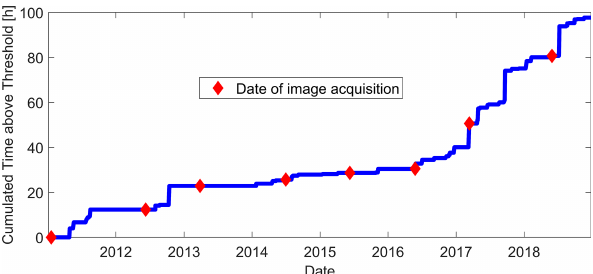
Figure 6. Effective transport time, i.e., cumulative time spent by the Vieux-Habitants river above the threshold discharge of 45m 3 s − 1 .